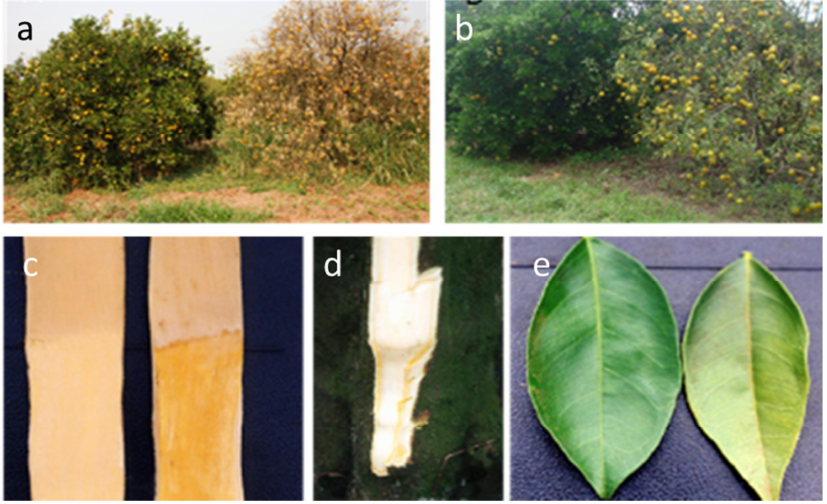
Figure 9. Defoliation, decline and death of trees by citrus sudden death ( a , b ), yellow stain in the phloem of the Rangpur lime rootstock ( c , d ), and discoloration and browning of leaves ( e ). (Courtesy of